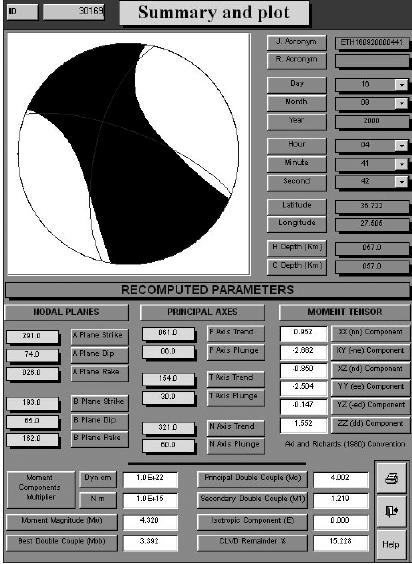
Fig. 4. Summary and plot window (lines indicate best double couple nodal planes).